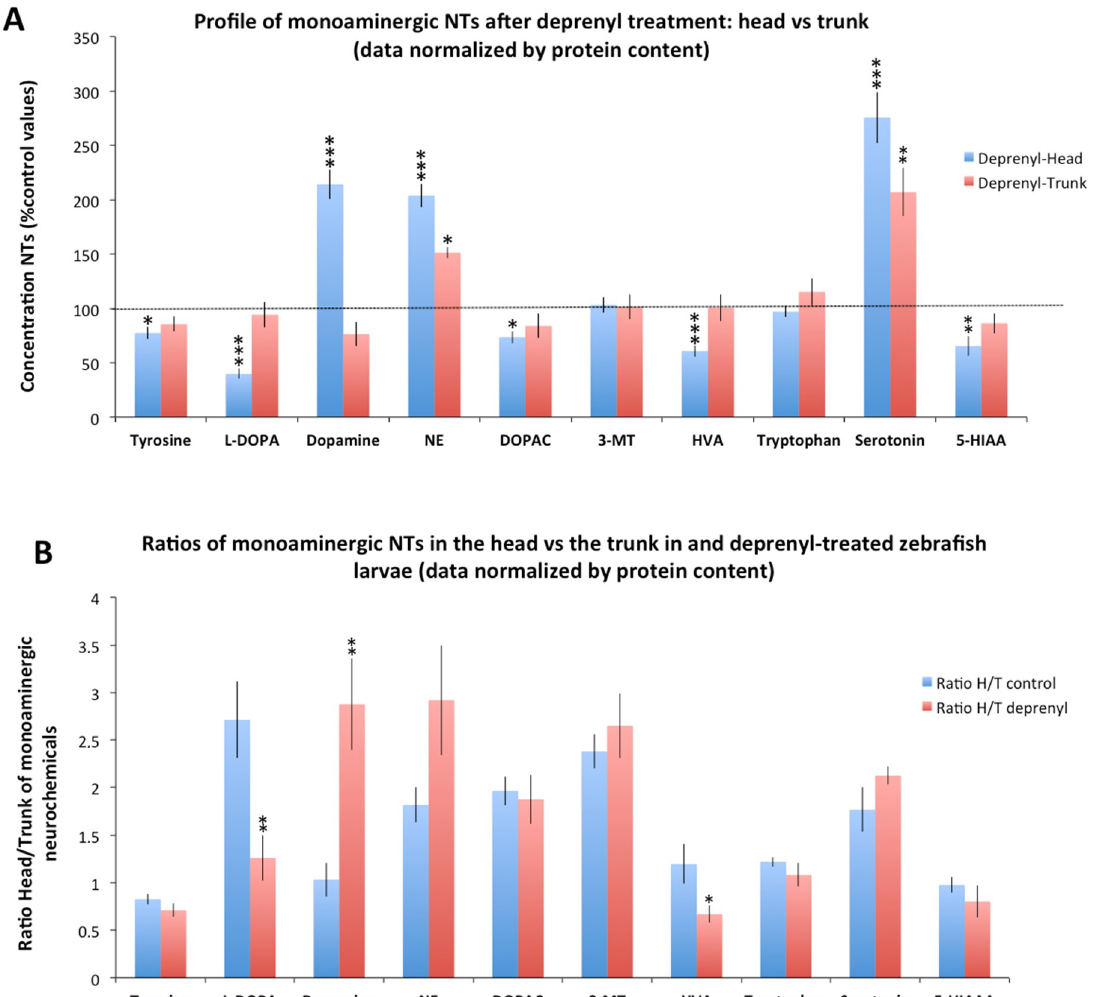
Figure 2. Distribution of monoaminergic neurochemicals between the head and trunk of zebrafish larvae exposed to 5 µM deprenyl for 24 h. ( A ) Concentration of monoaminergic neurochemicals in the head and trunk of larvae exposed to deprenyl, expressed as a percentage of the control values; ( B ) Ratio of head/trunk for the ten selected monoaminergic neurochemicals in control and deprenyl-treated zebrafish larvae. Data was normalized by protein content. Student’s t -test (n = 8 pools); * p < 0.05, ** p < 0.01, *** p < 0.001; Data from 2 independent experiments.